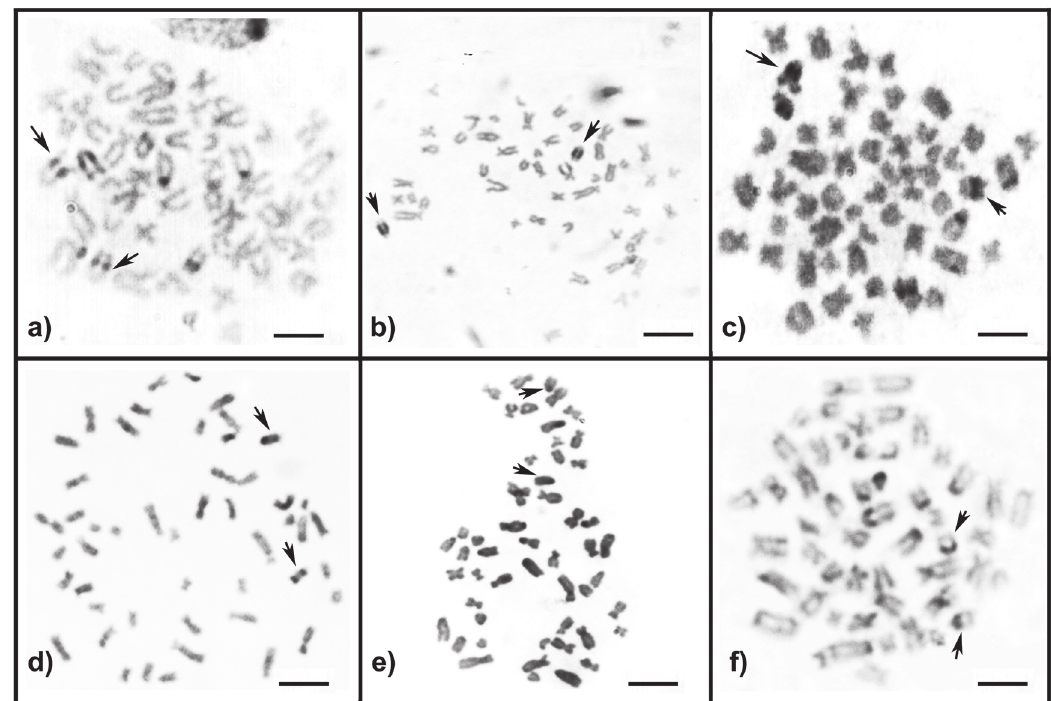
Fig. 3. Metaphases of Ancistrus with C band showing chromosomes NOR positive with large heterochromatin block (arrows). Bars 10 μ